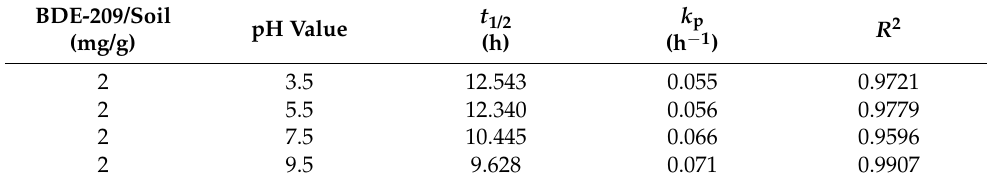
Table 4. Photolysis kinetic parameters of BDE-209 in soil suspensions under different pH